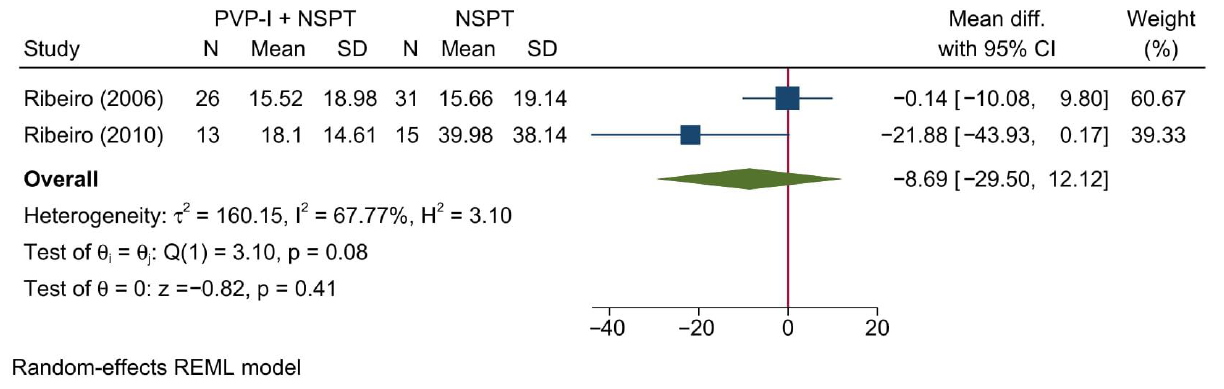
Figure 10. Forest plot showing the comparison between PVP-I + NSPT and NSPT alone regarding BAPNA [31,46].